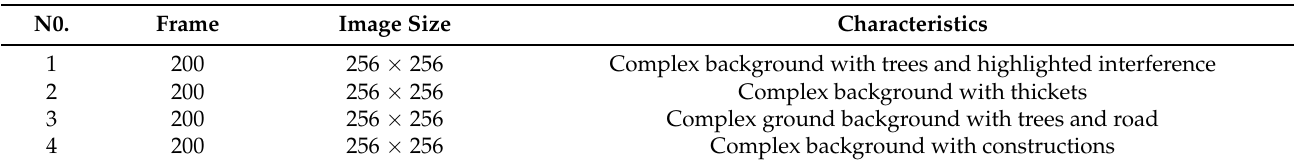
Table 2. Detailed description of experimental